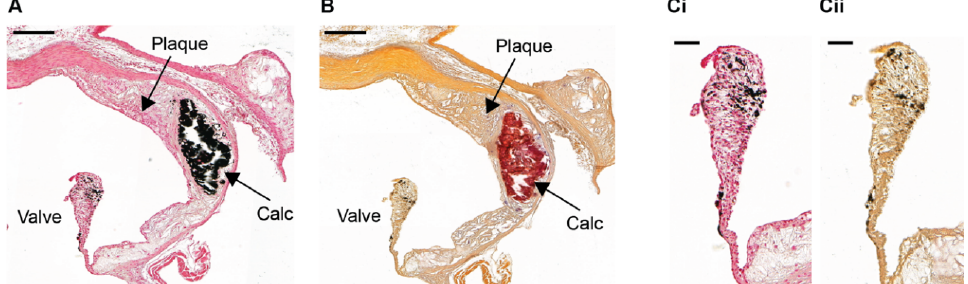
Figure 1. Detection of arterial intimal calcification in aortic root sections from an ApoE -/- mouse. Serial sections of a formalin-fixed aortic root from a 10-week old ApoE -/- mouse fed a high fat, high Serial sections of a formalin-fixed aortic root from a 10-week old ApoE − / − mouse fed a high cholesterol diet for 28 weeks stained with ( A ), ( C )/( i ) von Kossa or ( B ), ( C )/( ii ) alizarin red S to detect calcification (Calc). Von Kossa-stained tissue sections were counterstained with nuclear fast red. False-positive black staining is detected in both the ( C )/( i ) von Kossa and ( C )/( ii ) alizarin red S stained aortic valve due to the presence of melanocytes. ( A ), ( B ) Scale bar = 200 µm. ( C )/( i-ii ) Scale bar = 50 µm.